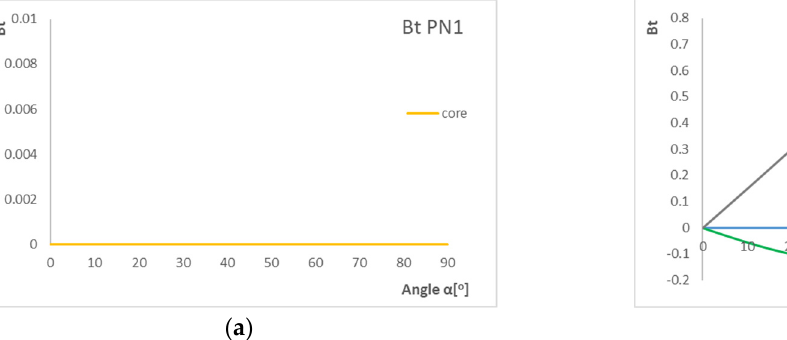
Figure 7. Influence of layer angle α in laminate with PN1 stacking sequence on B t coefficient ( a ) for core and ( b ) for strips and final configuration.